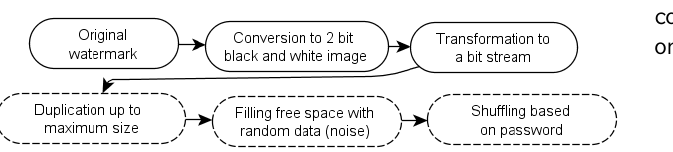
Fig. 5. Steps for the preparation of a watermark for embedding (optional steps marked with a dashed